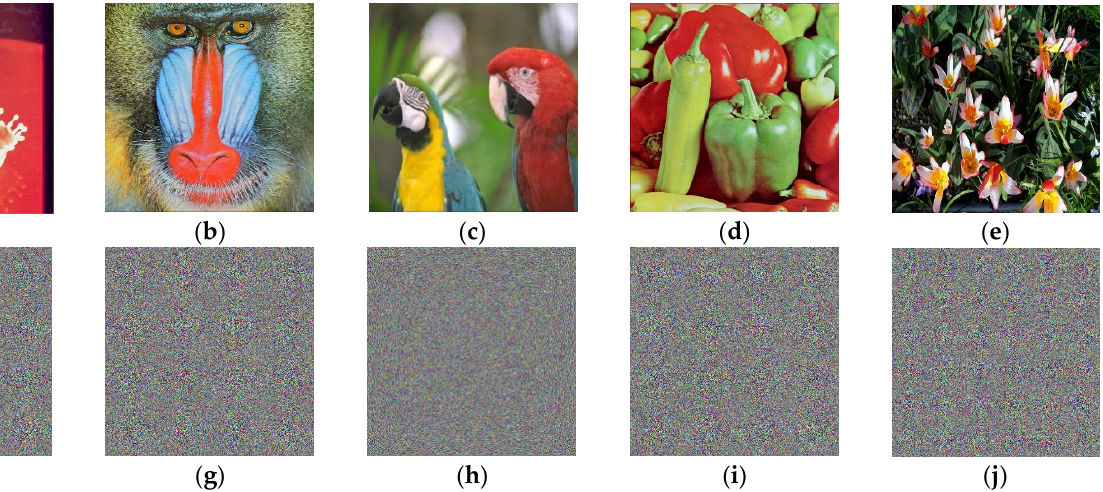
Figure 3. ( a – e ) Original standard color images; ( f – j ) respective ciphers yielded by the offered scheme.